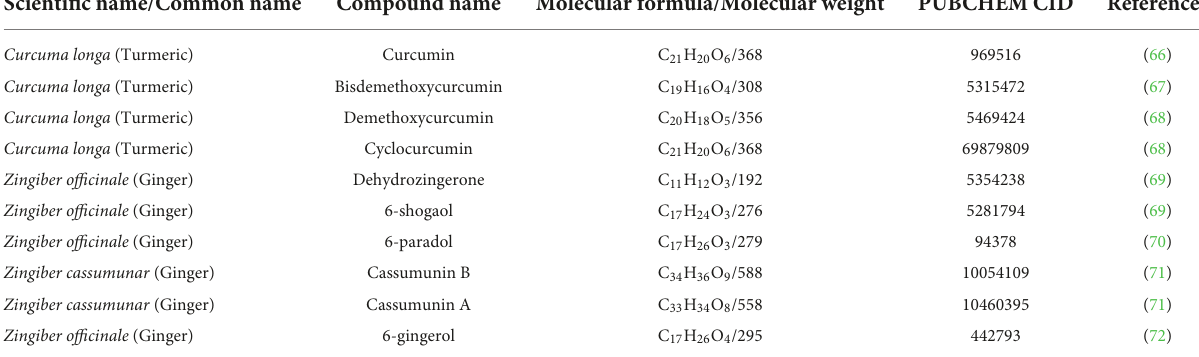
TABLE 2 List of natural derivatives and analogs of